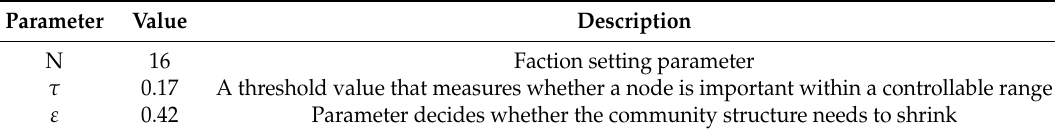
Table 2. The optimal parameter value of our